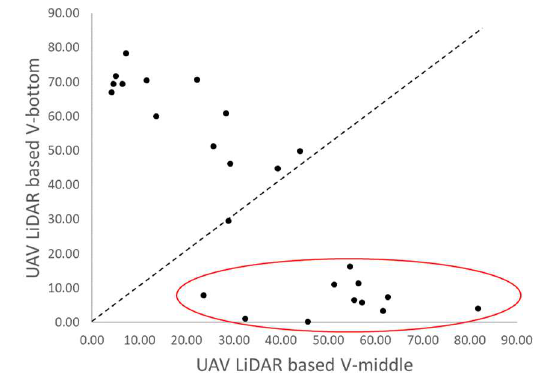
Figure 7. Comparison between UAV LiDAR based V-bottom and V-middle in 25 vegetation plots. Circled plots show too few V-bottom values compared to their V-middle values.